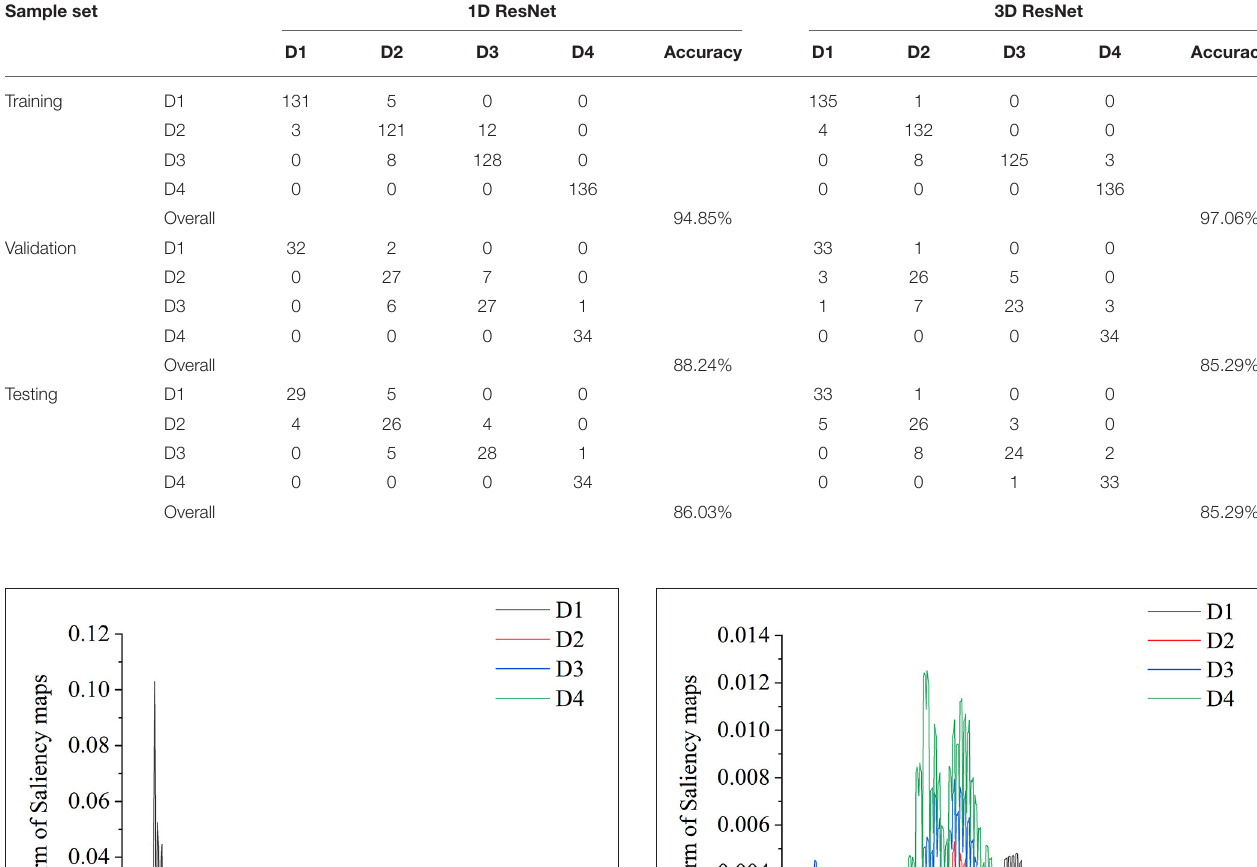
TABLE 2 | Confusion matrix of 1D and 3D ResNet model for strawberry maturity degree identification. Sample set